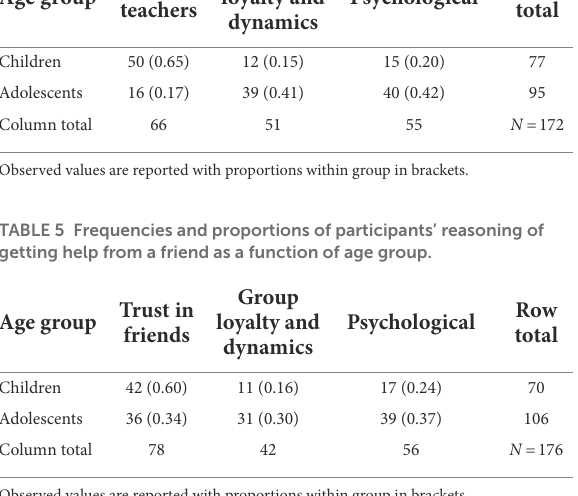
TABLE 4 Frequencies and proportions of participants’ reasoning of getting help from a teacher or an adult as a function of age group. Trust in Age group teachers